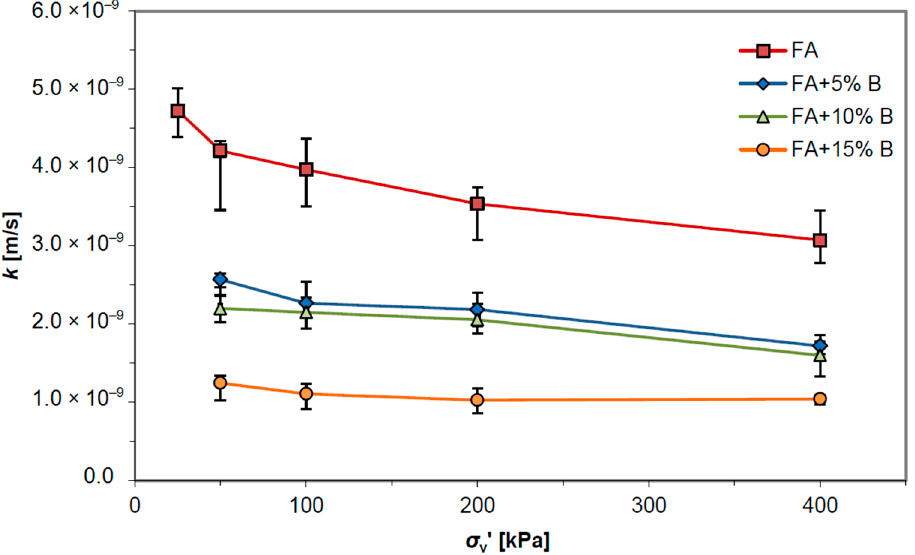
Figure 8. The hydraulic conductivity of tested materials in relation to effective stress at hydraulic gradient i = 32.